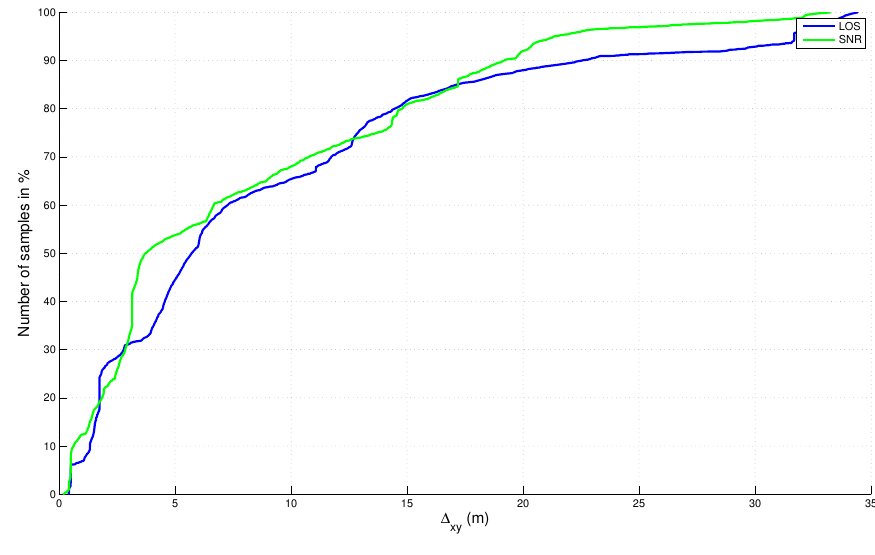
Figure 8. Cumulative distribution function of the absolute error in 2D for “free” solutions (without map-aiding).